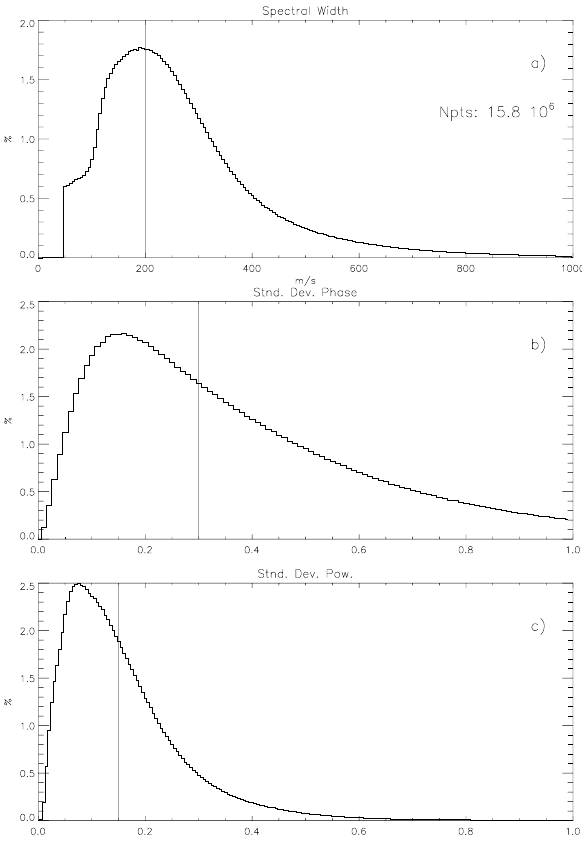
Fig. 3. Density probability of (a) spectral width, (b) standard devi- Fig.3. Densityprobabilityofa)spectralwidth,b)standarddeviationonthephaseandc)standarddeviation ation on the phase and (c) standard deviation on the power. Vertical on the power. Vertical lines show the thresholdsused in this classification scheme for eachparameter. lines show the thresholds used in this classification scheme for each 20